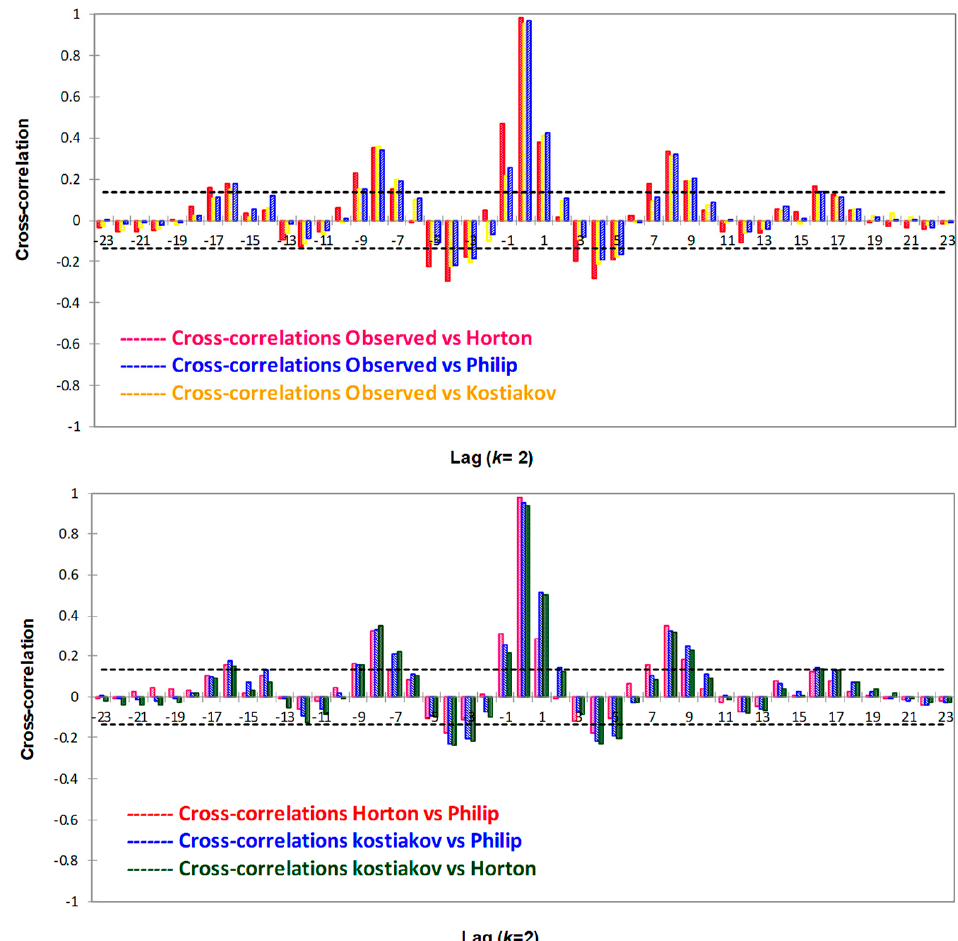
Figure 6. ( a ) Overall linear dependency of observed versus simulated infiltration rates at all site locations. ( b ) Overall behavior of the models’ simulations compared to the overall field measure- ments.